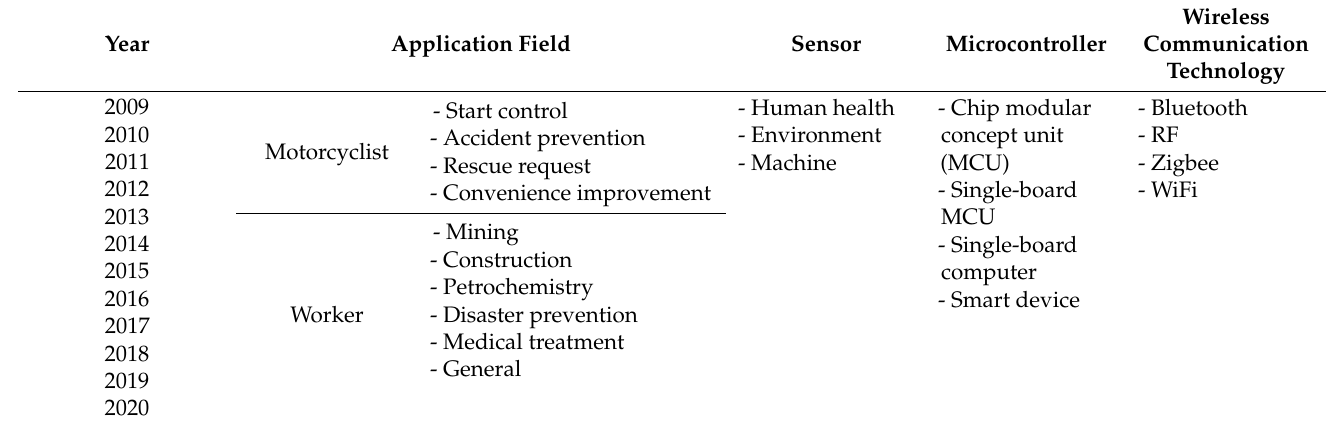
Table 1. Outline of results for each research question.